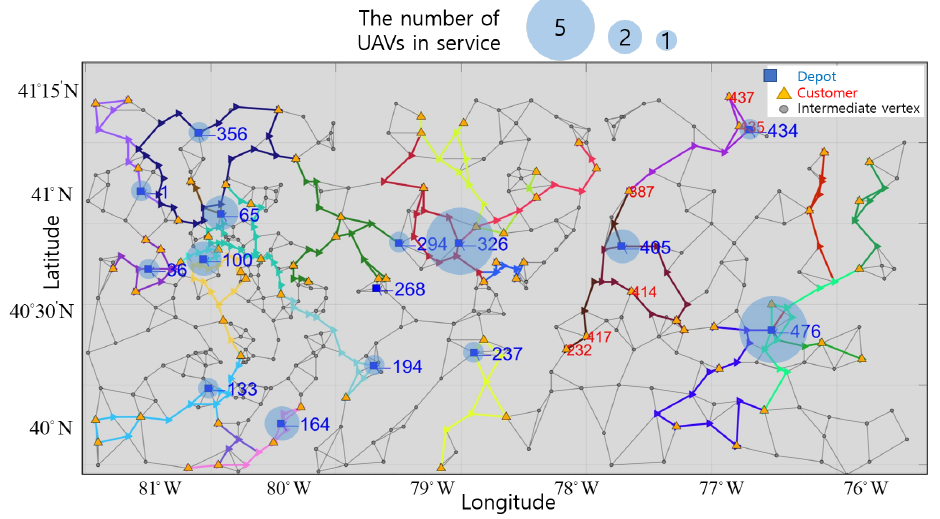
Figure 8. Optimal round-trips of UAVs in the virtual network.